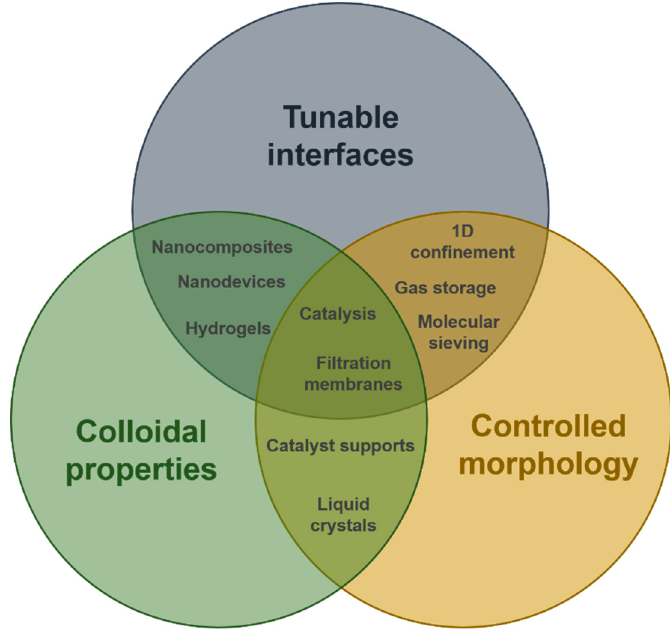
Figure 9. Schematic illustration of imogolite nanotubes properties (circles) and their combined uses for different applications.